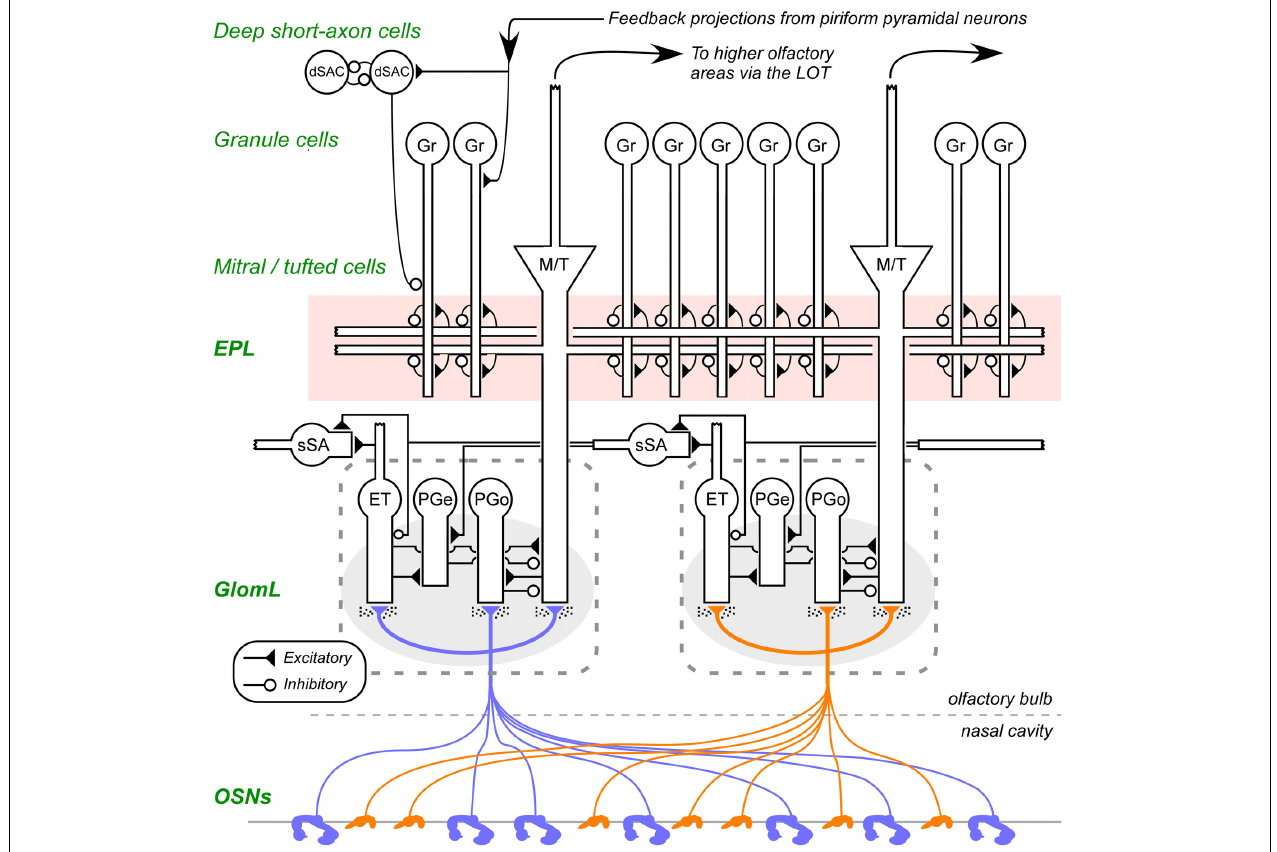
FIGURE 1 | Circuit diagram of the mammalian olfactory bulb. The axons of olfactory sensory neurons (OSNs) expressing the same odorant receptor type converge and arborize together to form glomeruli (shaded ovals; two depicted) on the surface layer of the olfactory bulb. Intrinsic OB interneurons innervate each glomerulus, including olfactory nerve driven periglomerular cells (PGo), external tufted cell-driven periglomerular cells (PGe), and external tufted cells (ET). Superficial short-axon cells (sSA), closely related to PG cells and possibly part of the same heterogeneous population, are not associated with specific glomeruli but project broadly and laterally within the deep glomerular layer. Principal neurons include mitral cells and tufted cells (collectively depicted as M/T), which interact via reciprocal connections in the external plexiform layer (EPL) with the dendrites of inhibitory granule cells (Gr), thereby receiving